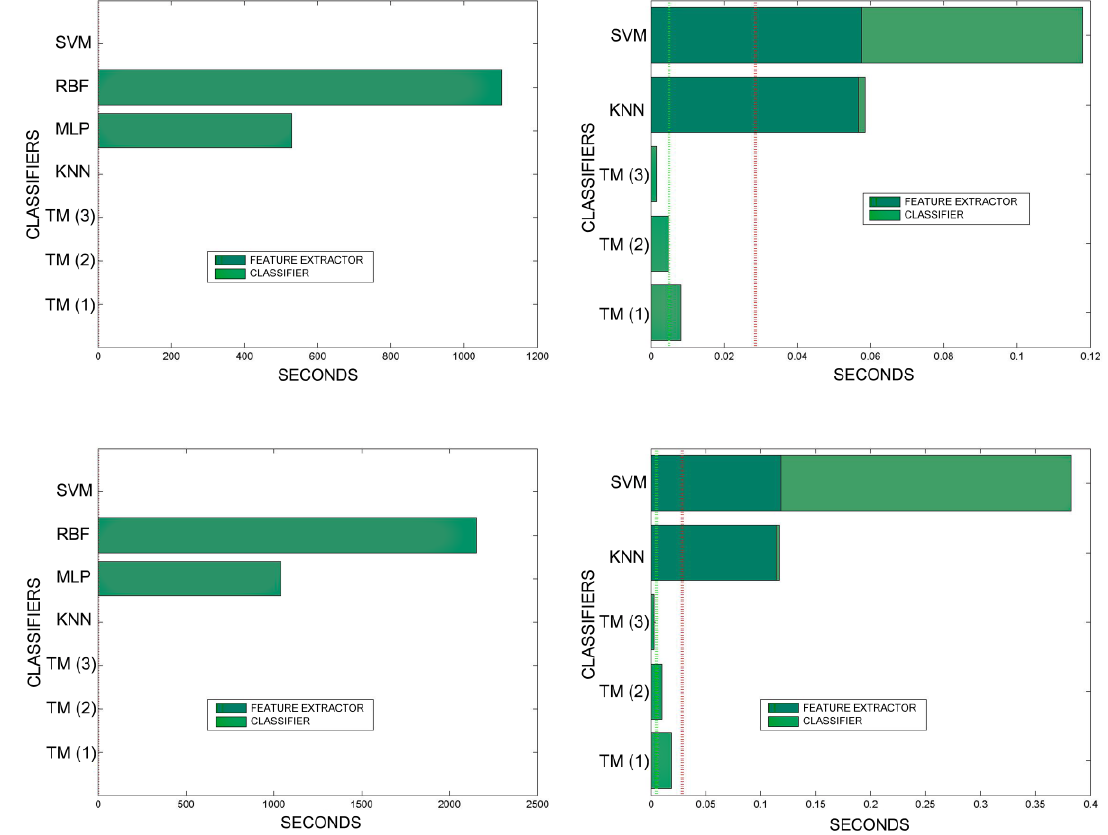
Figure 24. Comparison of training times. 10 averaged training sets of 10% and 20% of total training samples. The graphs on the left show all the classifiers. In the graphs on the right, the RBF and MLP classifiers have been removed in order to better appreciate the training times of the other classifiers. The TM training times are so reduced that they are not appreciated in the graph. This is because TM training consists simply of adding morphologies to the morphological family